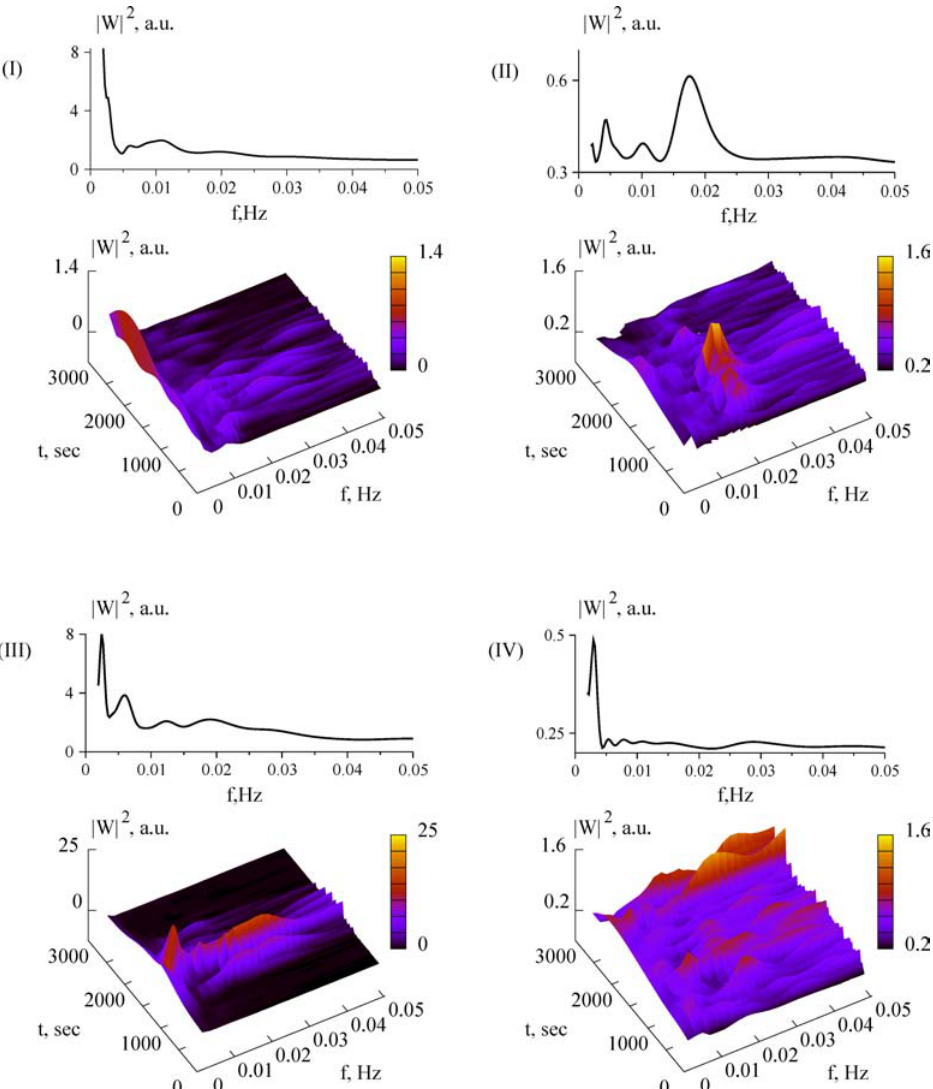
Fig. 7. Patterns of rhythmic activity in di®erent regions of interest as indicated in Fig. 4(a). N A ¼